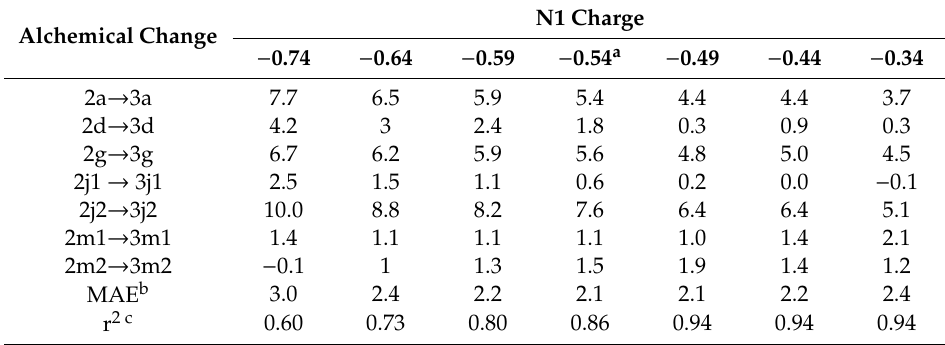
a Charge used in the simulations. b Mean absolute error (MAE) is calculated between the calculated and experimental values for compounds a , d , g , and m ; where for compound m the average between poses m1 and m2 is taken. c r 2 Correlation coe ffi cient (values are calculated without the j1